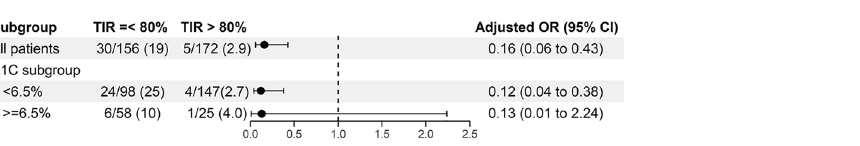
Figure 2. Adjusted odds ratios of the time in range of relative normoglycemia > 80% for in-hospital mortality according to A1C levels. TIR time in range, OR odds ratio, CI confidence